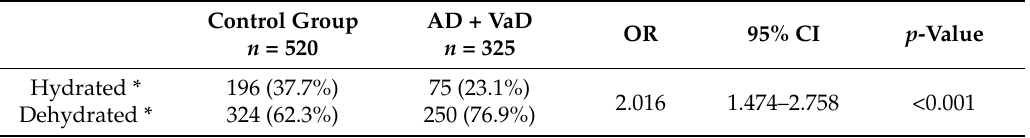
Table 3. Logistic regression analysis of dehydration risk in control group and patients with Alzheimer’s disease (AD) and vascular dementia